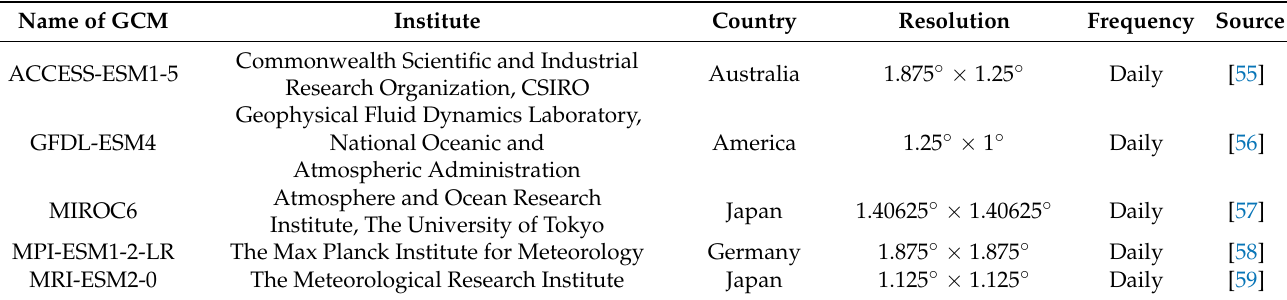
Table 1. Detailed information on GCMs selected in this